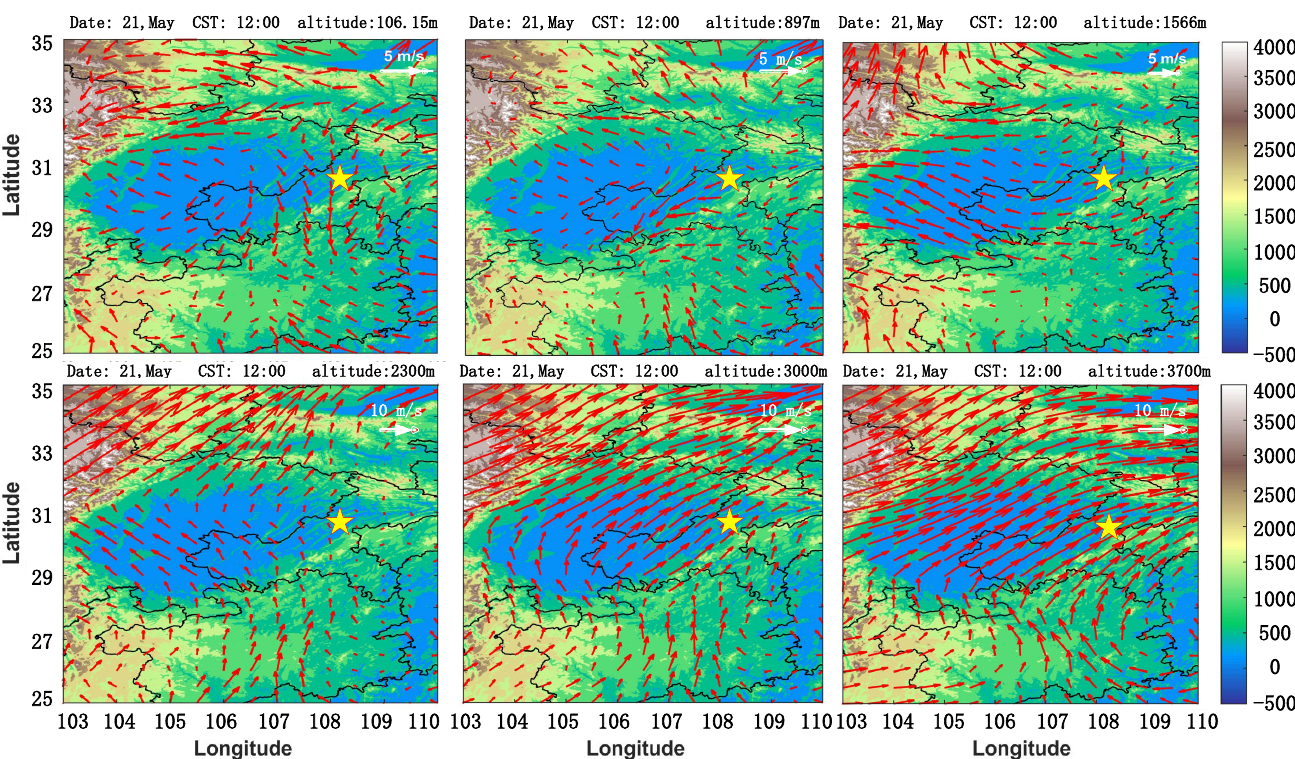
Figure 5. Wind speed and direction from the ERA5 reanalysis at different heights; the yellow five-pointed star represents the campaign site.